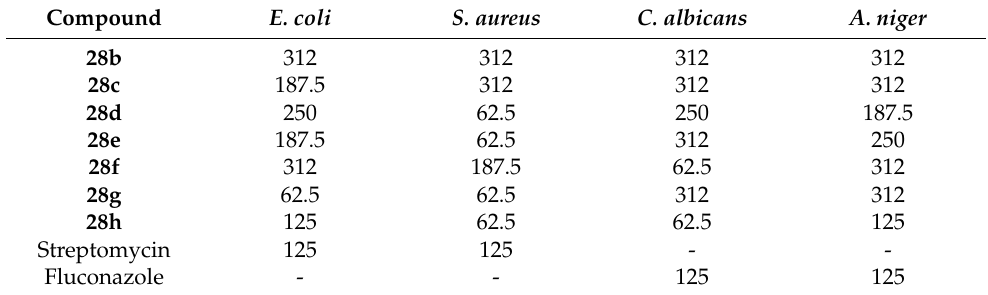
Table 1. Antibacterial and antifungal activities of the compounds 28a – 28h indicated by MIC ( µ g mL − 1 ). Compound